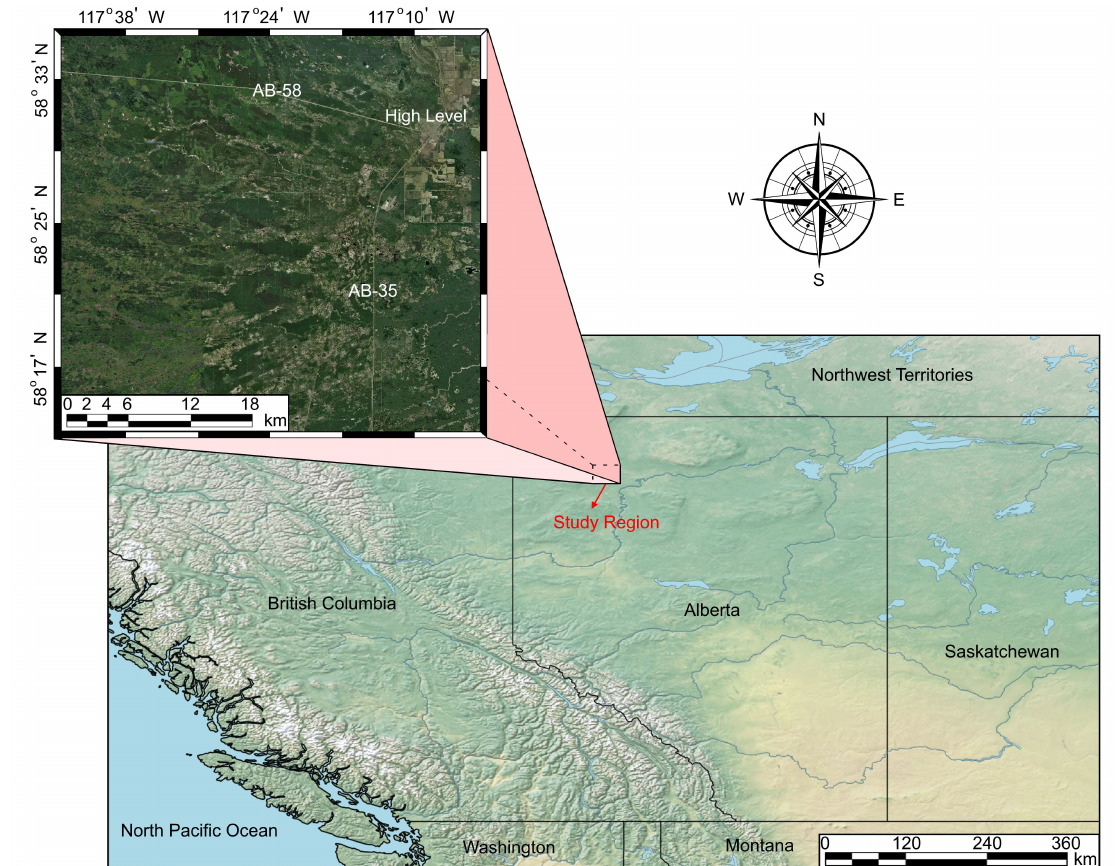
Figure 1. Study region: A forested region in northern Alberta, Canada. The enlarged section shows a view of the study region in April 2020, provided by the Environmental Systems Research Institute